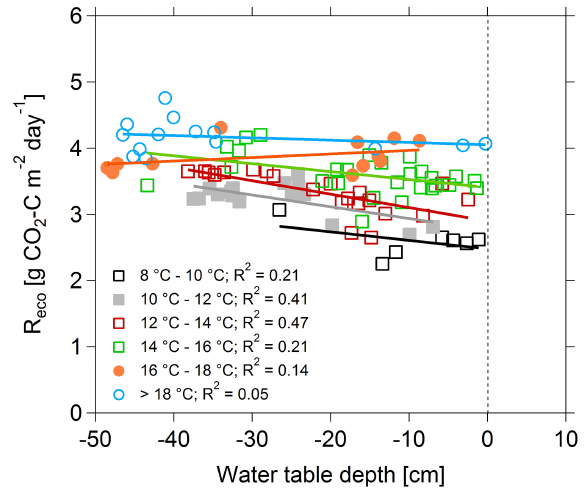
Figure 8. Ecosystem respiration as a function of water table depth and air temperature (daily means for May–September 2013).